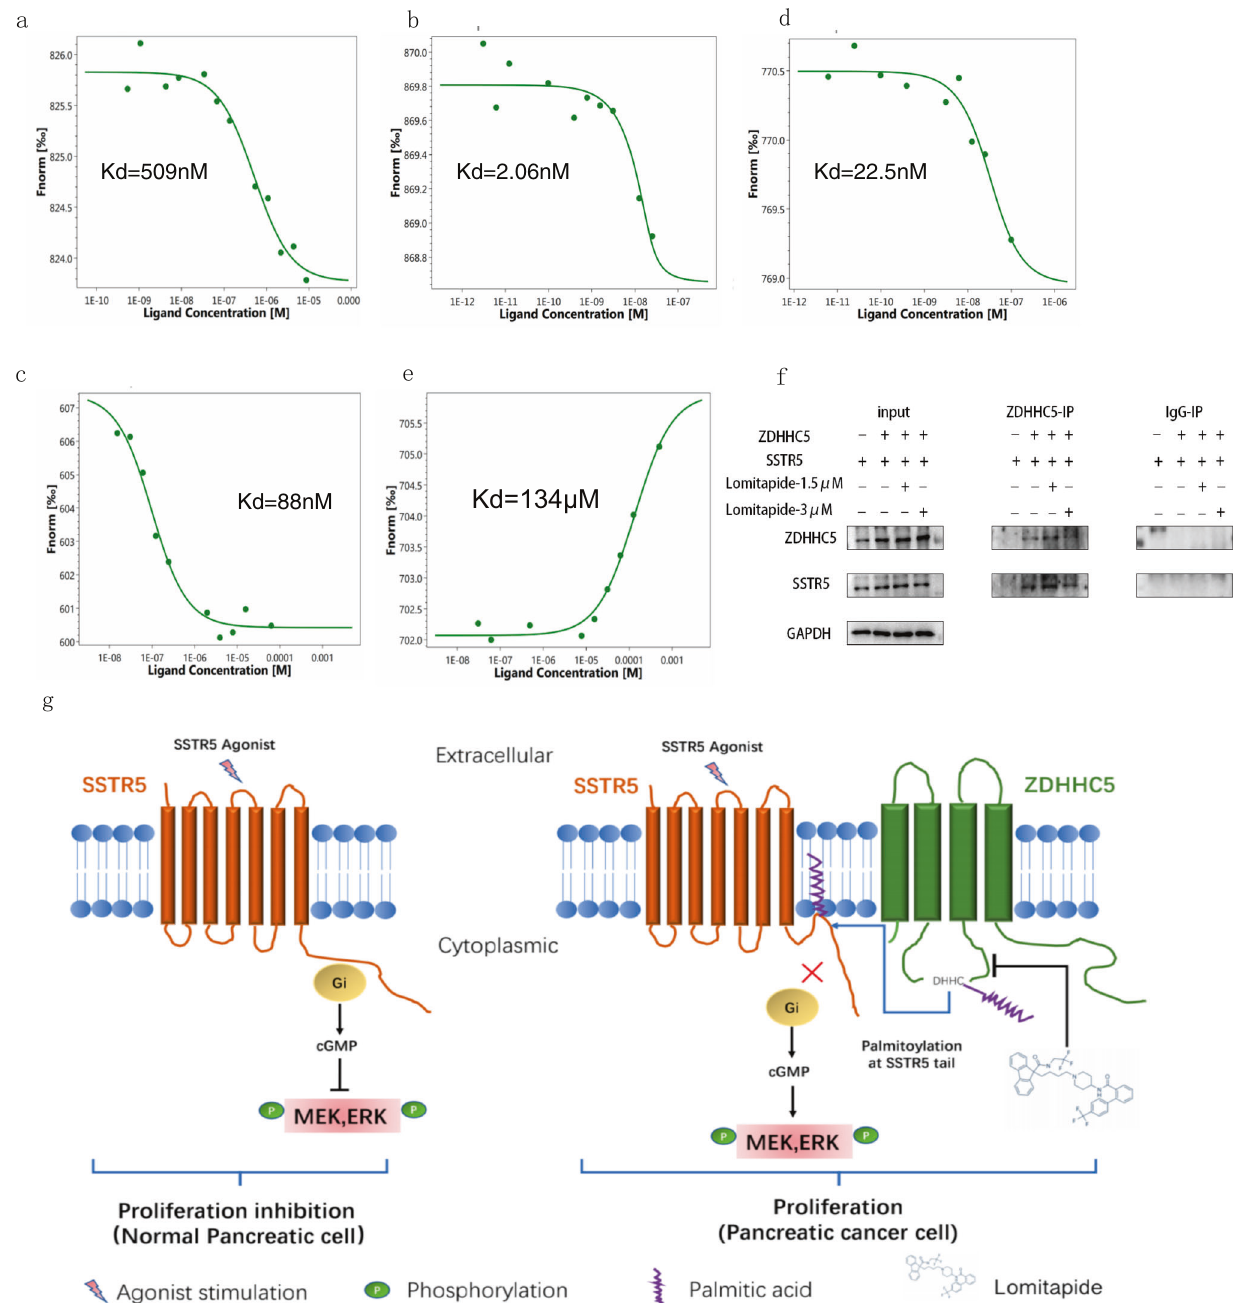
Fig. 5 Mechanism of Lomitapide ’ s inhibition of palmitoylation mediated by ZDHHC5. a Binding of Lomitapide and ZDHHC5 substrate domain. b Binding of SSTR5 (307 – 362 aa) and ZDHHC5 substrate domain. c Binding of Palmitic acid and ZDHHC5 substrate domain. d In the presence of 25 μ M Lomitapide, binding of SSTR5 (307 – 362 aa) and ZDHHC5 substrate domain. e In the presence of 25 μ M Lomitapide, binding of Palmitic acid and ZDHHC5 substrate domain. f Co-IP assay showing that SSTR5 interacted with ZDHHC5 in HEK293T cell, and lomitapide inhibits their combination. g As shown in the mechanism diagram, we propose that Lomitapide inhibits pancreatic cancer proliferation by competitively binding the ZDHHC5 substrate to the binding region of SSTR5 and Palmitic acid, preventing